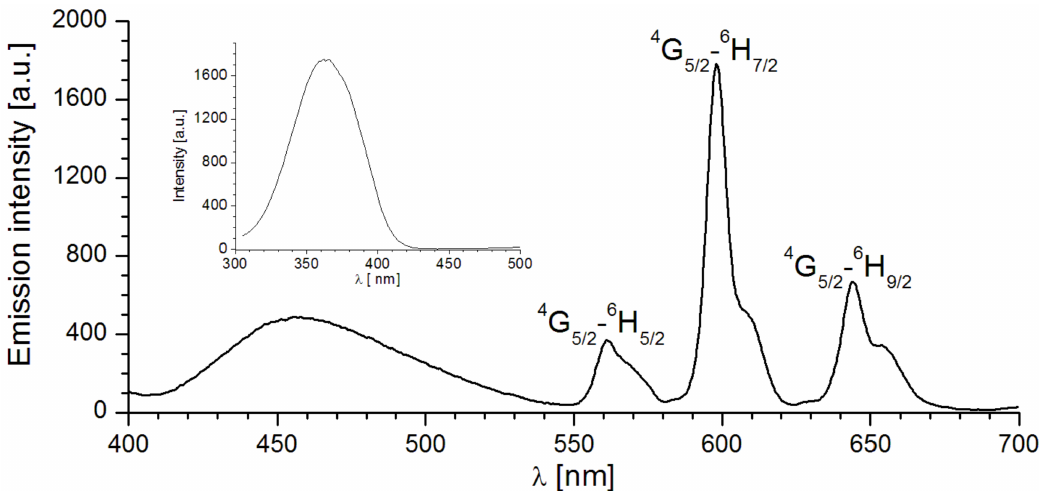
Figure 6. Photoluminescent spectrum of 2 (Zn II –Sm III –Zn II ) in methanol solution; the inset is the excitation spectrum of the studied